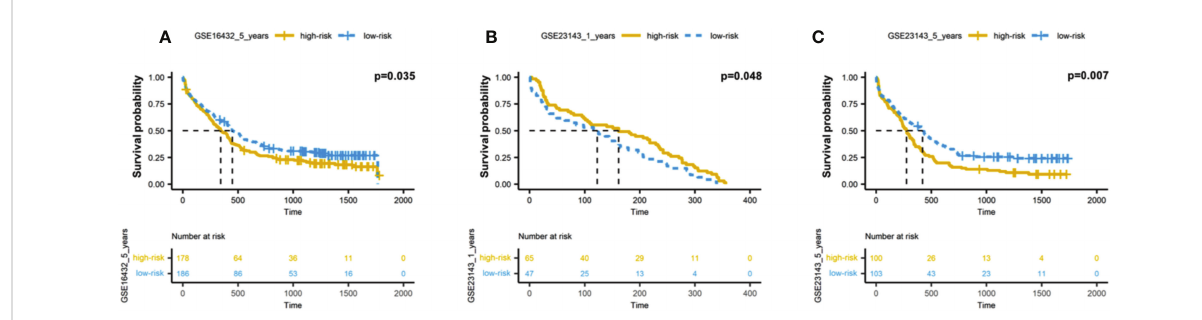
FIGURE 5 Validation of autophagy-associated prognostic model in independent AML cohort. (A-C) Kaplan-Meier analysis of 6-month (A) , 1-year (B) and 3-year (C) survivals based on the 12 autophagy-associated genes in GSE23143